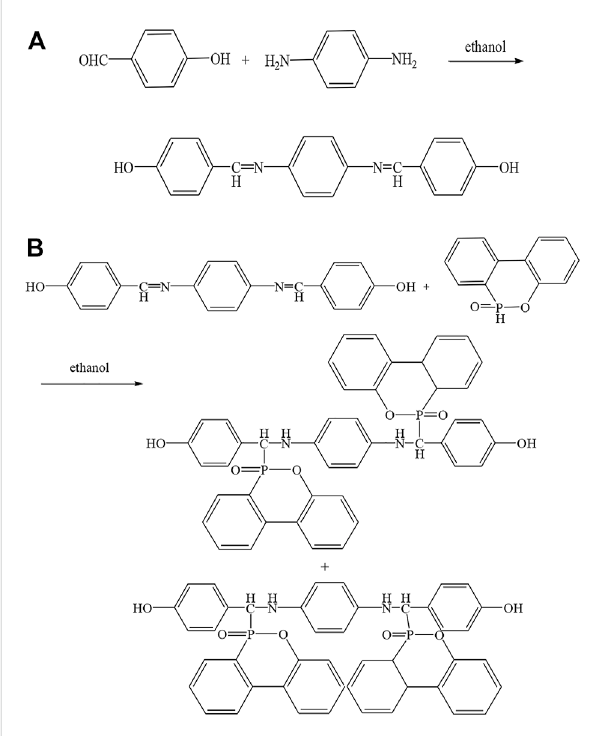
Synthetic chemical equation of (A) the imine compounds and (B)